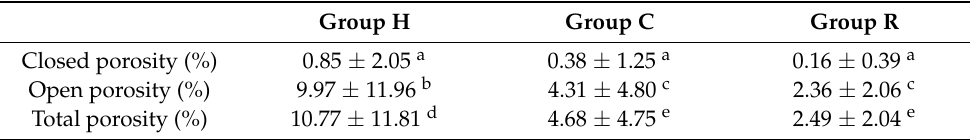
Table 5. The percentage volume of porosity (%) in group H, C, and R.